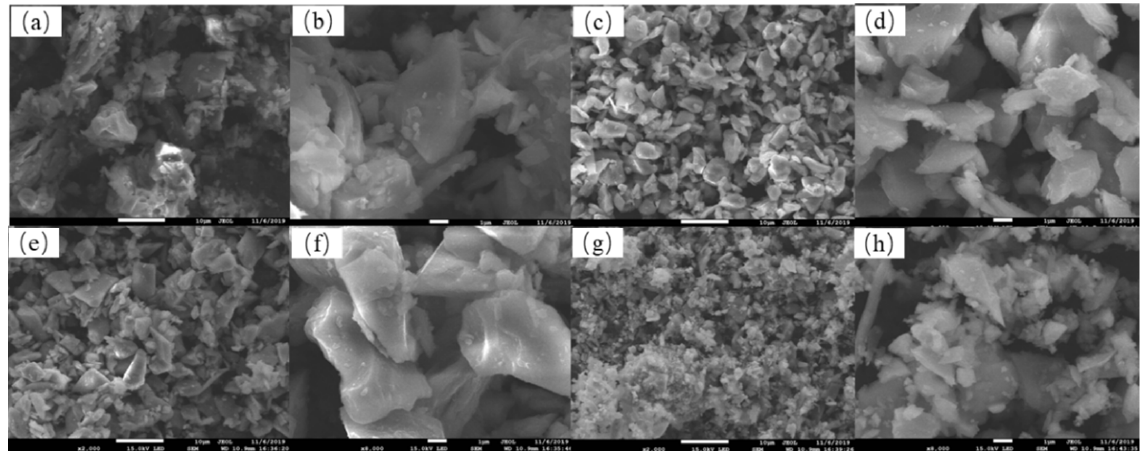
Figure 1. SEM images of S1 ( a ) ×2000 and ( b ) ×8000, S2 ( c ) ×2000 and ( d ) ×8000, S3 ( e ) ×2000 and ( f ) ×8000 and S4 ( g ) ×2000 and ( h ) ×8000. ( a , b ) were reproduced from Ref. [8] with permission from Elsevier.